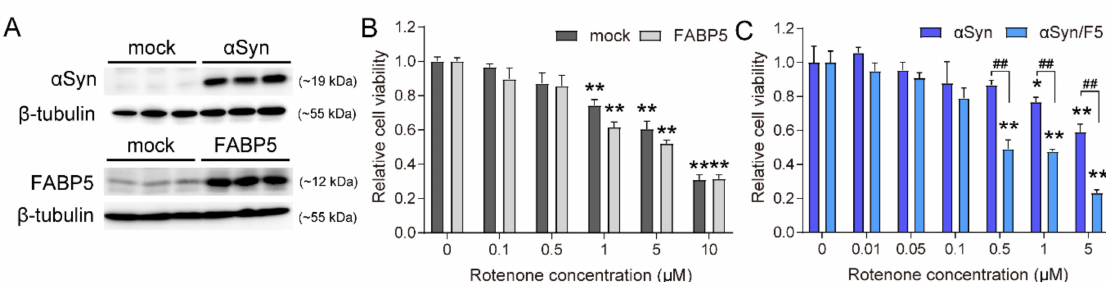
Figure 1. Rotenone induced neurotoxicity, especially with co-overexpression of FABP5 and α -Synuclein. ( A ) Representative images of immunoblots probed with antibodies against α Syn (~19 kDa) and FABP5 (~12 kDa). Blots with anti- β -tubulin antibody showed that a similar amount of protein was loaded. ( B , C ) Viability of Neuro-2A cells treated with indicated concentrations of rotenone for 48 h was assessed using CCK-8 assays. The transfection conditions were pcDNA 3.1- transfected cells (mock) and FABP5-transfected cells in ( B ); α Syn-transfected cells and α Syn/FABP5-transfected cells ( α S/F5) in ( C ). Results are presented as means ± SEM (n = 4 parallel cell experiments). * p < 0.05, ** p < 0.01, vs. 0 µ M rotenone groups; ## p < 0.01 vs. α Syn-transfected cells. CCK-8: cell counting